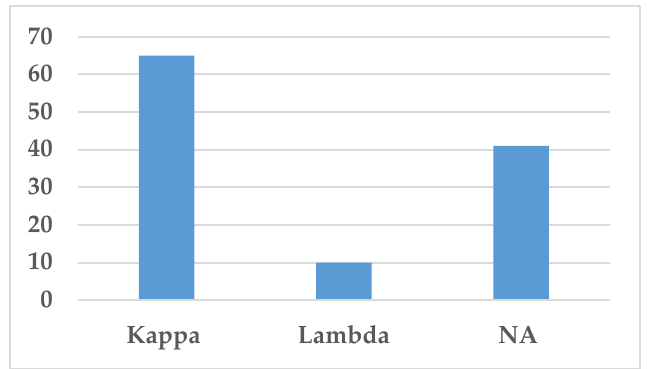
Figure 6. Distribution of light chains. This figure demonstrates the distribution of light chains found in the serum by protein electrophoresis or immunofixation. Abbreviation: NA—Not available.